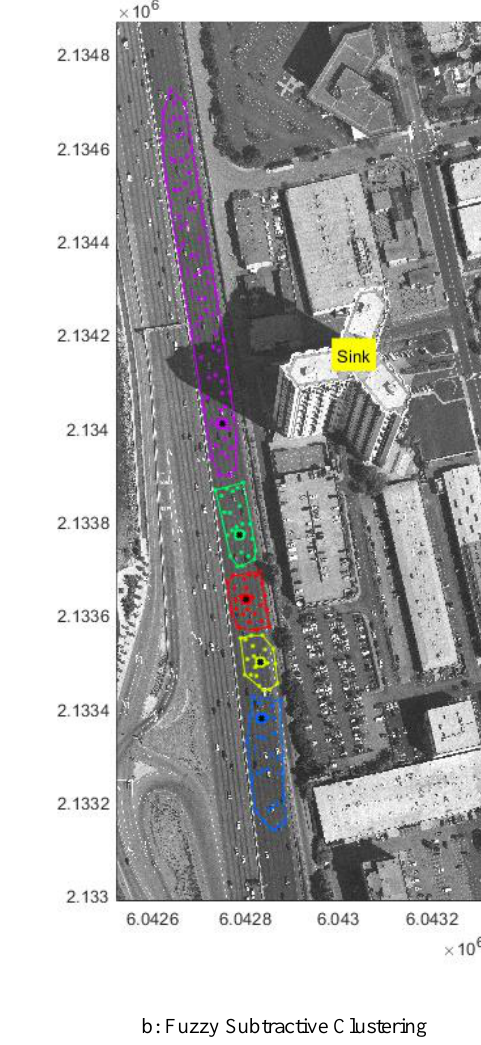
Figure 6. The clustering obtained by applying the FCM and Fuzzy Subtractive algorithms, clusters are shown by different colors and the cluster-heads are shown by bolded